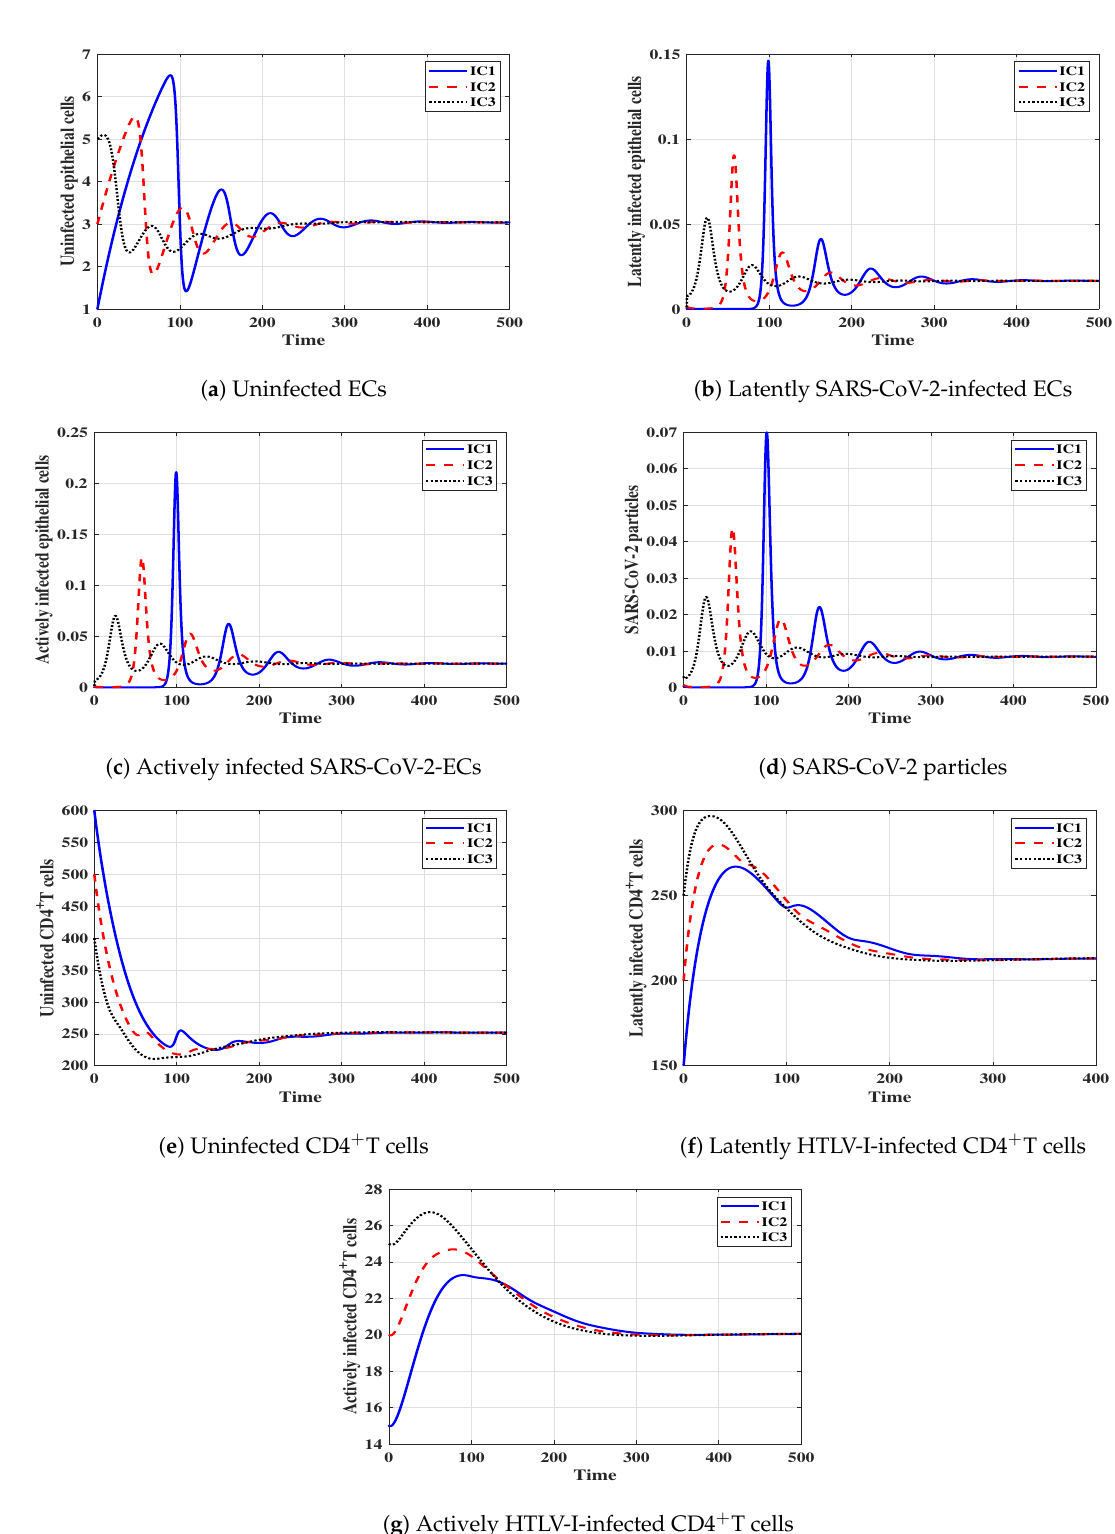
Figure 4. Solutions of system (7)–(13) with initial conditions IC1–IC3 in Case